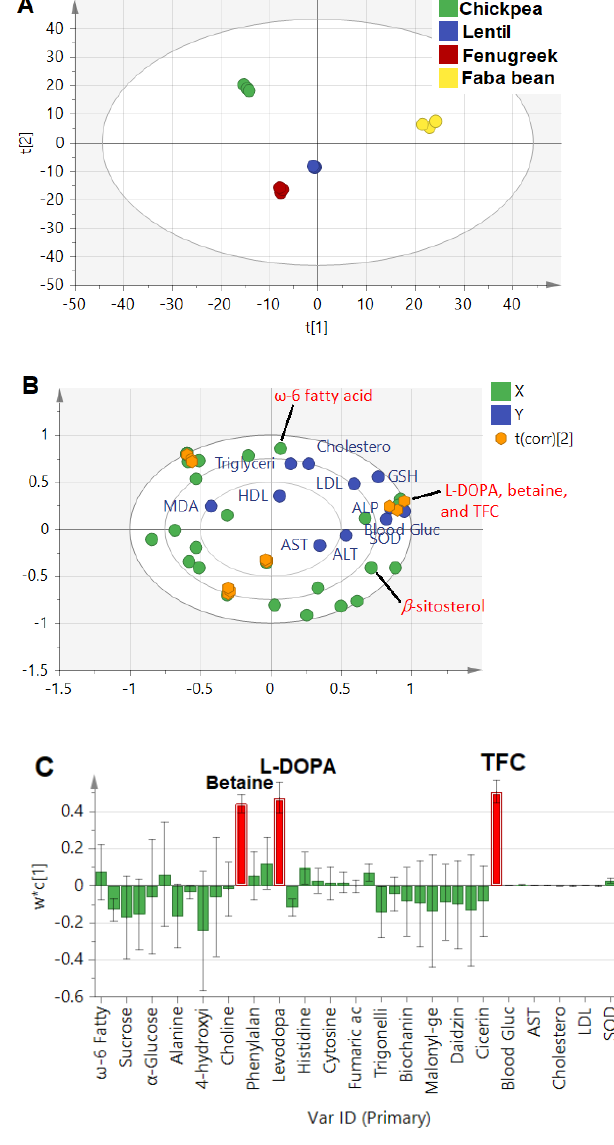
Figure 4. ( A ): PLS score plot of investigated legume sprouts based on quantified metabolites by NMR and total flavonoid content (TFC). ( B ): Biplot relating the quantified metabolites (X − Variables) correlated with investigated parameters (Y − Variables) related to the antidiabetic activity, and ( C ): Loading bar plot showed the positive correlation of the antidiabetic activity with identified metab ‐ olites and TFC. The t(corr)[2] sign denotes the correlation sites between X − and Y − variables.